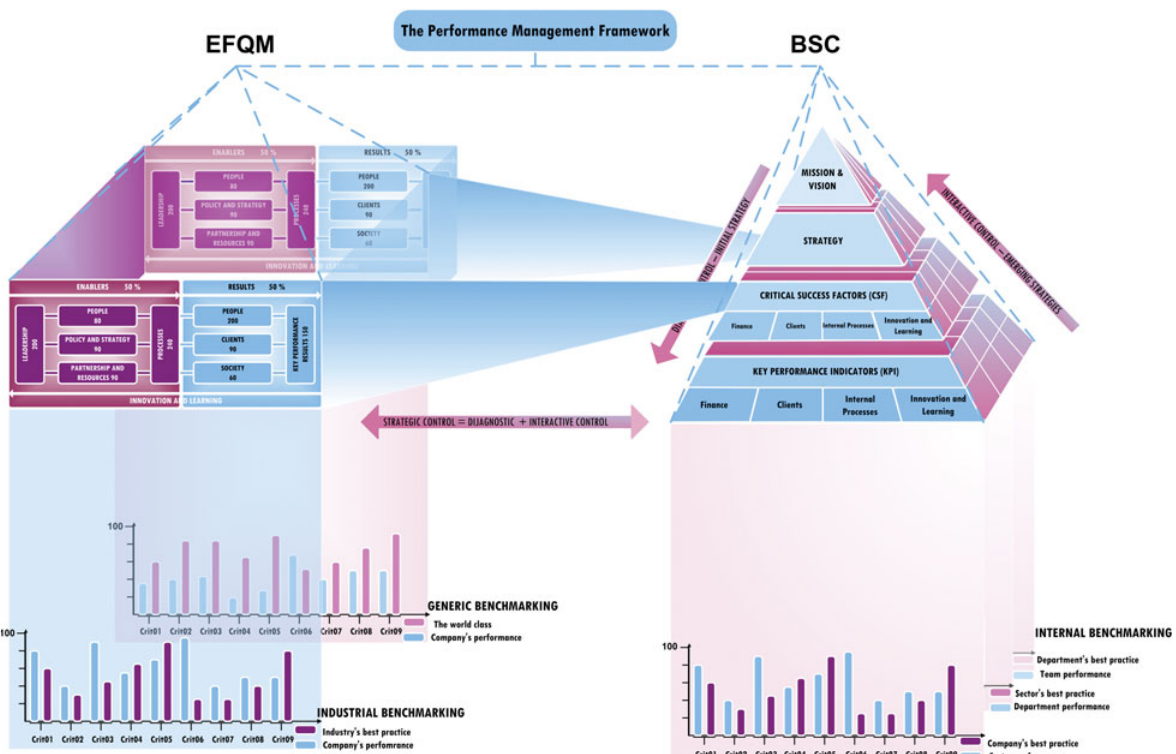
Fig. 3. The two sides of the performance management